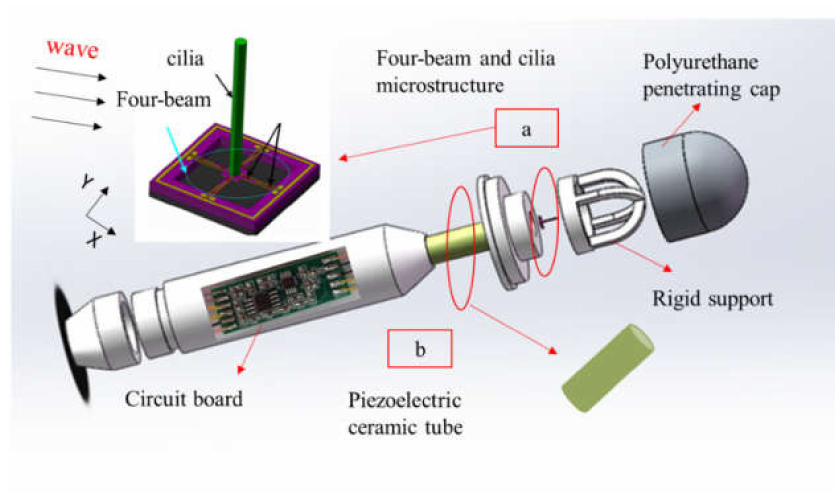
Figure 1. The assembly drawing of vector hydrophone. ( a ) four-beam and cilia microstructure; ( b ) piezoelectric ceramic tube.